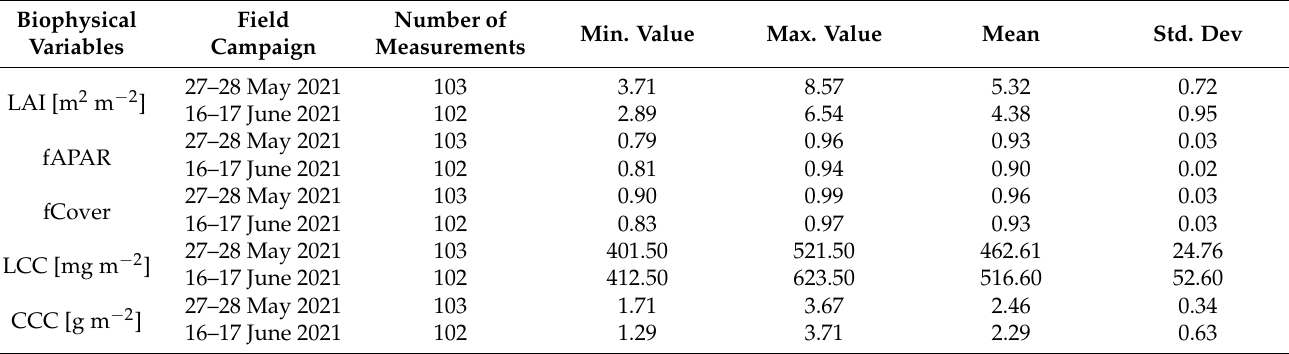
Table 2. Descriptive statistics for the ground-measured biophysical variables of winter durum wheat during the two field campaigns.